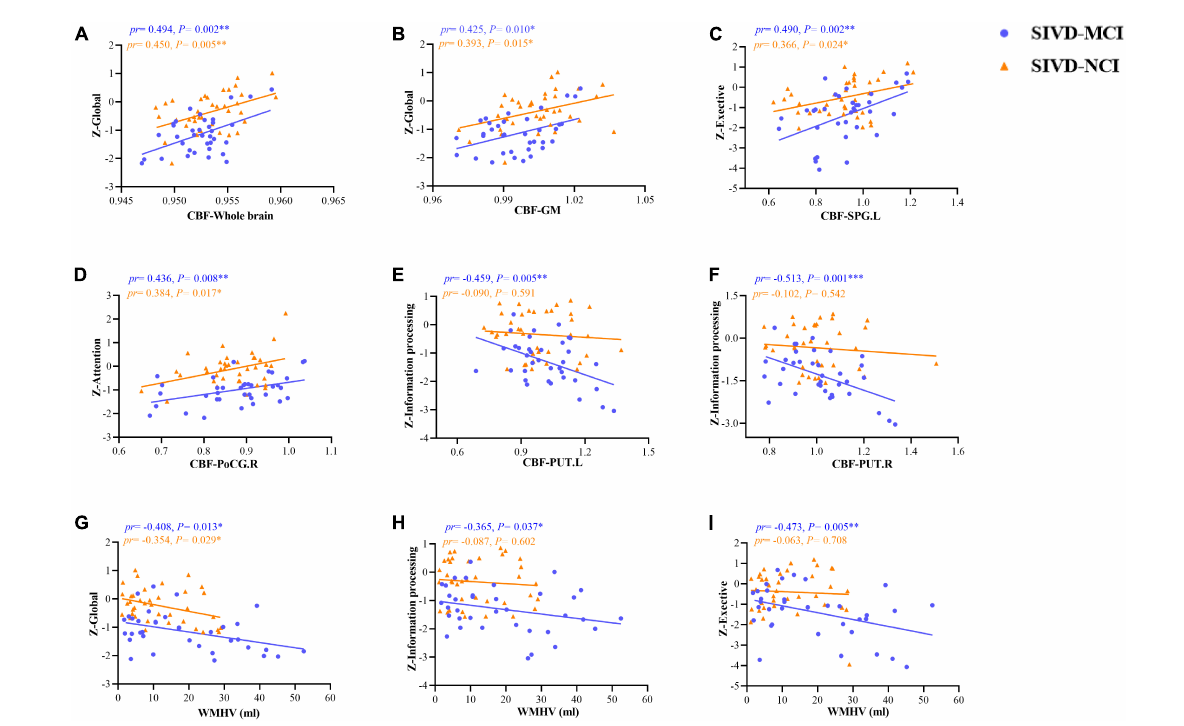
FIGURE5 Scatter plots of correlation between CBF, WMHV, and neuropsychological tests in patients with SIVD-MCI and SIVD-MCI. The blue dots represented the SIVD-MCI group, and the orange-yellow triangle represented the SIVD-NCI group. (A) Positive correlations between CBF in the whole brain and z -scores in global. (B) Positive correlations between CBF in the GM and z -scores in global. (C) Positive correlations between CBF in SPG.L and z -scores in exective function. (D) Positive correlations between CBF in PoCG.R and z-scores in attention function. (E) Negative correlations between CBF in PUT.L and z -scores in information processing function. (F) Negative correlations between CBF in PUT.R and z -scores in information processing function. (G) Negative correlations between WMHV and z -scores in global cognition. (H) Negative correlations between WMHV and z -scores in information processing function. (I) Negative correlations between WMHV and z -scores in executive function. pr, partial correlation coefficient; CBF, cerebral blood flow; GM, gray matter; PoCG, postcentral gyrus; SPG, superior